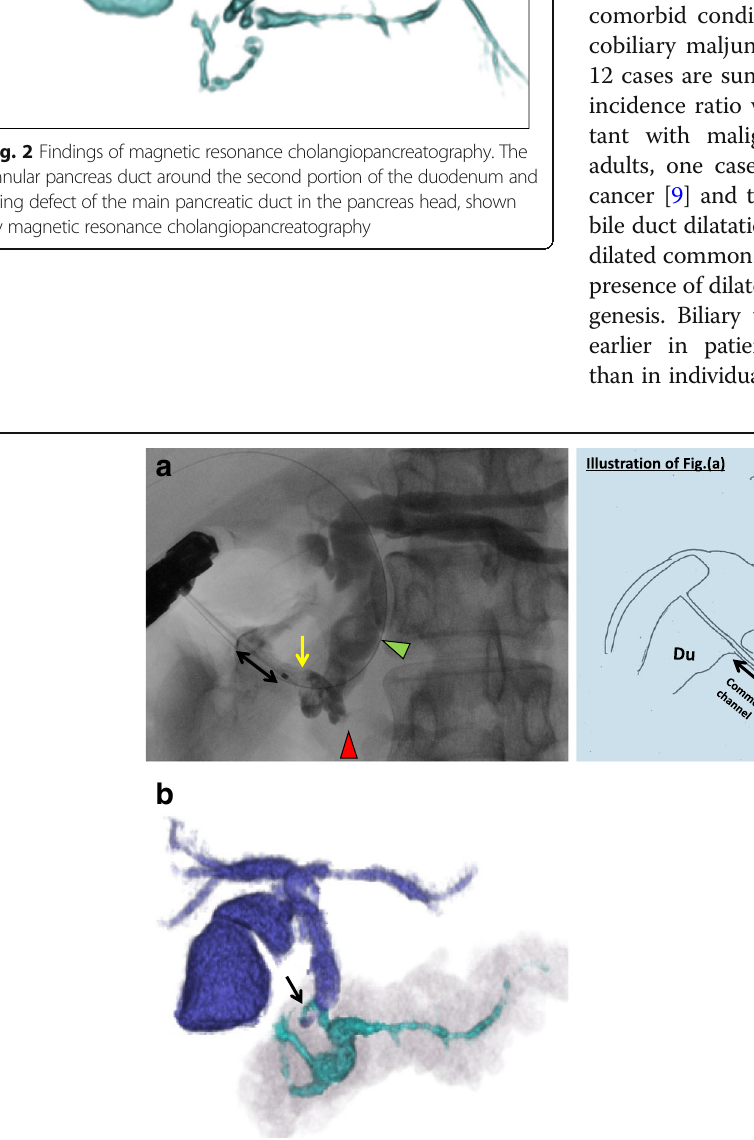
Fig. 3 Findings of endoscopic retrograde cholangiopancreatography and three-dimensional cholangiopancreatography by computed tomography data. A filling defect in the common bile duct due to choledocholithiasis (green triangle) and the main pancreatic duct in the pancreas head (red triangle), detected by endoscopic retrograde cholangiopancreatography; ERCP ( a ). And, the pancreatic duct joined near the lower common bile duct (arrow), and the common channel (two-way arrow) was revealed. Three-dimensional cholangiopancreatography ( b ) revealed joint portion of pancreatic duct and common bile duct and annular pancreatic duct. Pancreas duct distal to the filling defect was slightly